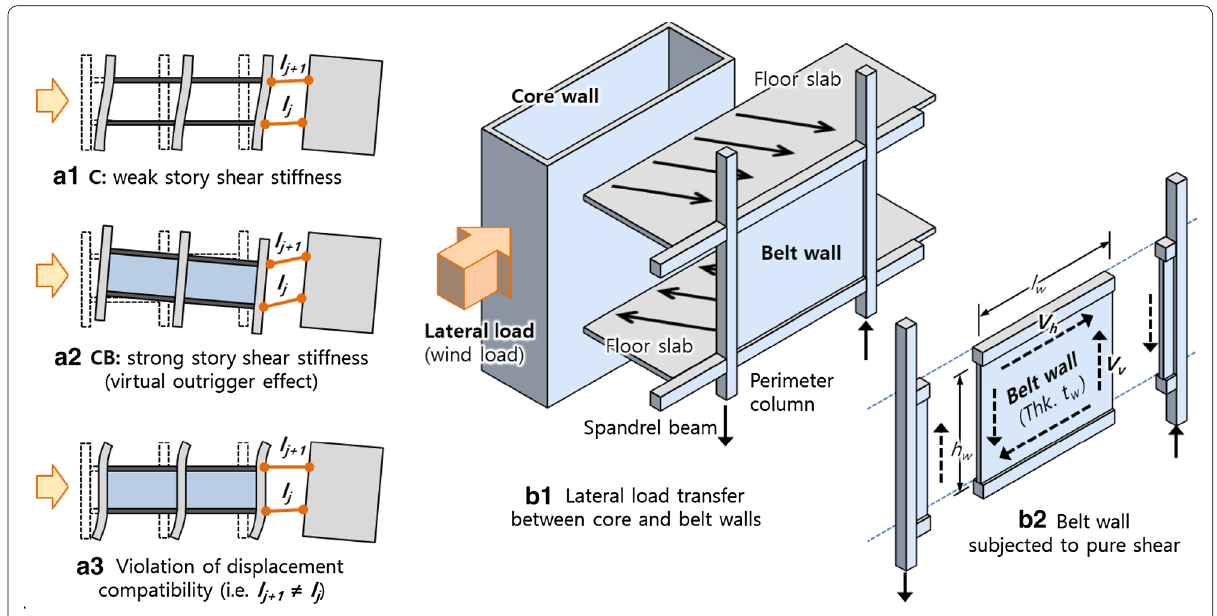
Fig. 7 Force transfer mechanism of distributed belt walls as virtual outrigger.